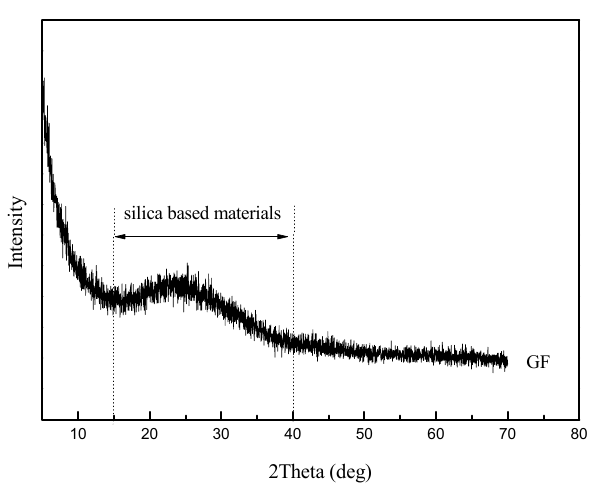
Figure 3. XRD patterns of GF.